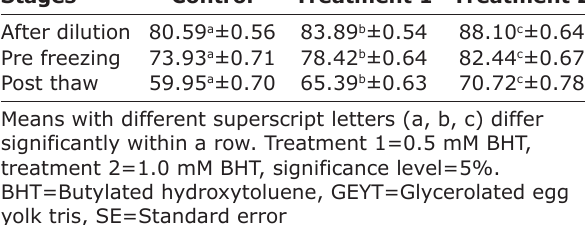
Table 2: Progressively motile spermatozoa in the semen of Hariana bulls extended in GEYT with BHT supplementation during different stages (after dilution and prefreezing) of cryopreservation and following thawing (mean±SEM, n=24).